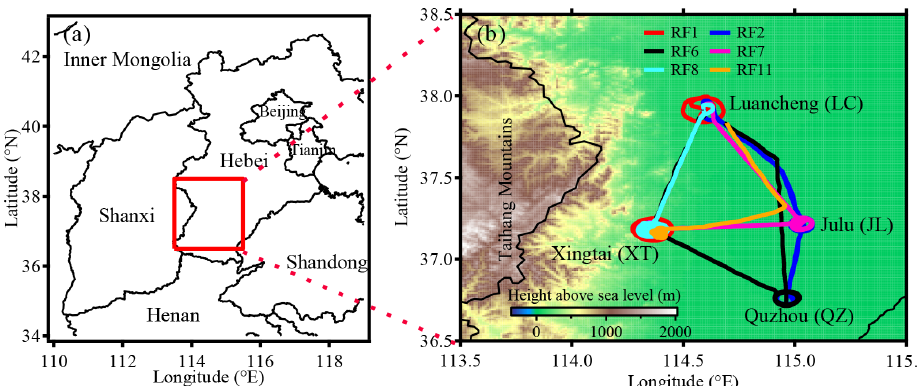
Figure 1. (a) The geographic location of Hebei Province and (b) flight tracks of six flights conducted over the southern plain of Hebei Province from 8 May to 11 June 2016. The colored background shows terrain heights above sea level (unit: m). The number after “RF” indicates the research flight